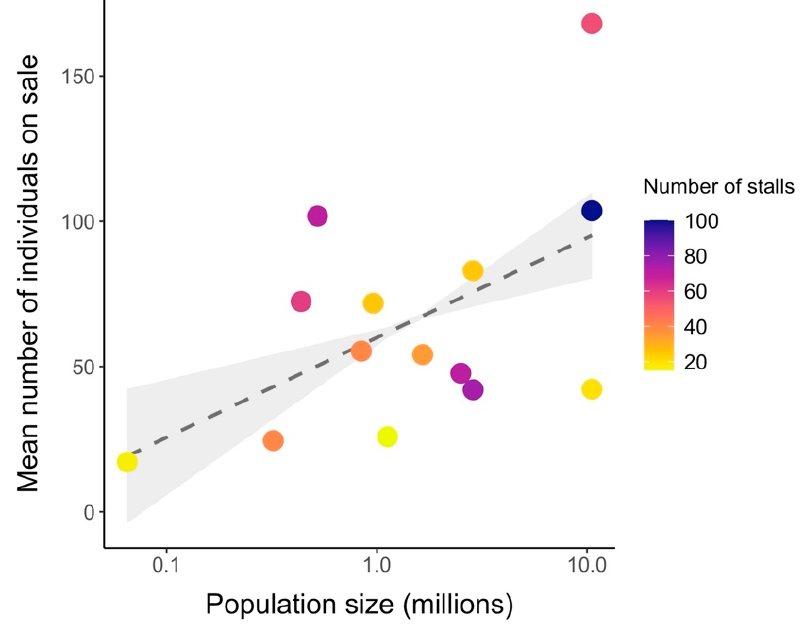
Figure 2. Relationship between human population size (in ln scale) of the surveyed city and mean number of primates, rodents, bats and carnivores on sale in wildlife markets in Indonesia. Each point is a sampled market, and the colour gradient refers to the estimated number of stalls selling wildlife in each market.